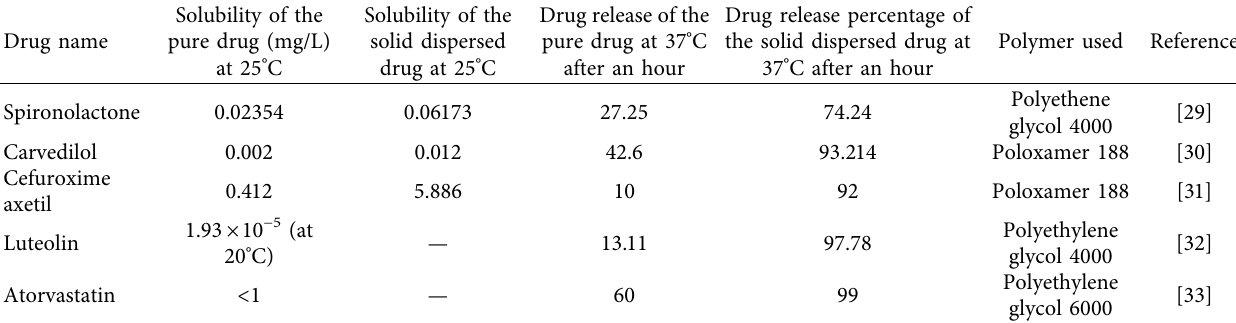
Table 4: Shows examples of decent case studies for the preparation of solid dispersion using the fusion method.